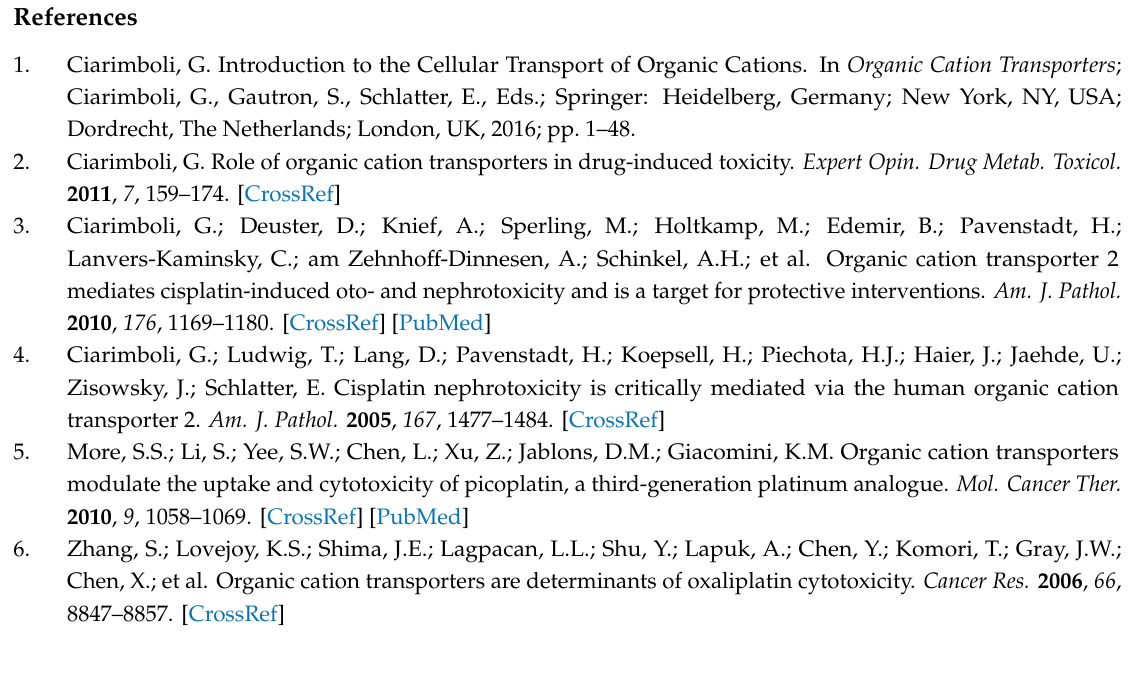
s1, Figure S1: Representative immunofluorescence analysis of hOCT2 expression, Figure S2: Representative immunofluorescence analysis of negative